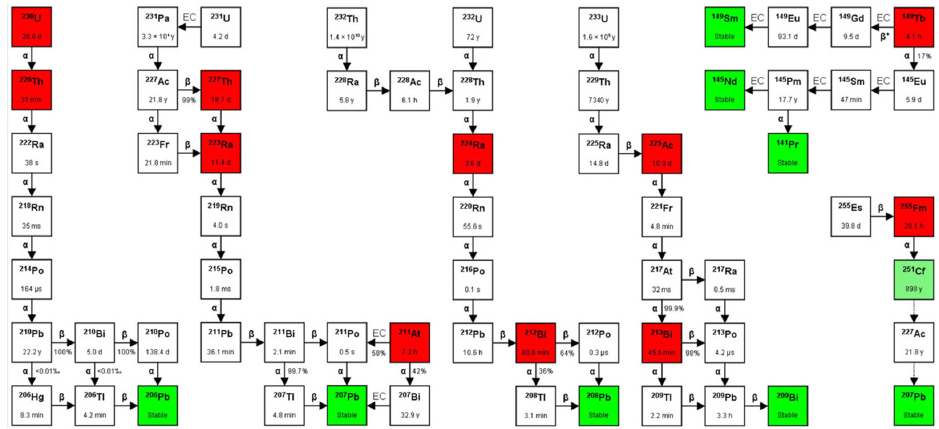
Figure 2. Decay chains of some common therapeutic α -emitters. Reproduced from [6], Frontiers,